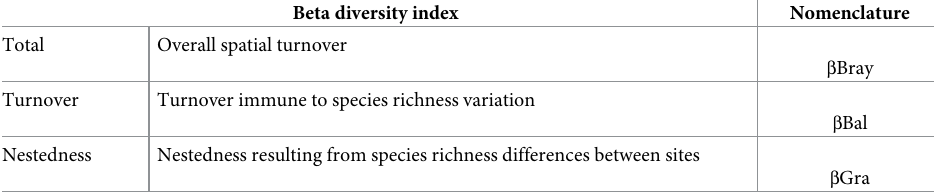
Table 1. Summary of beta diversity index and their nomenclatures used in this